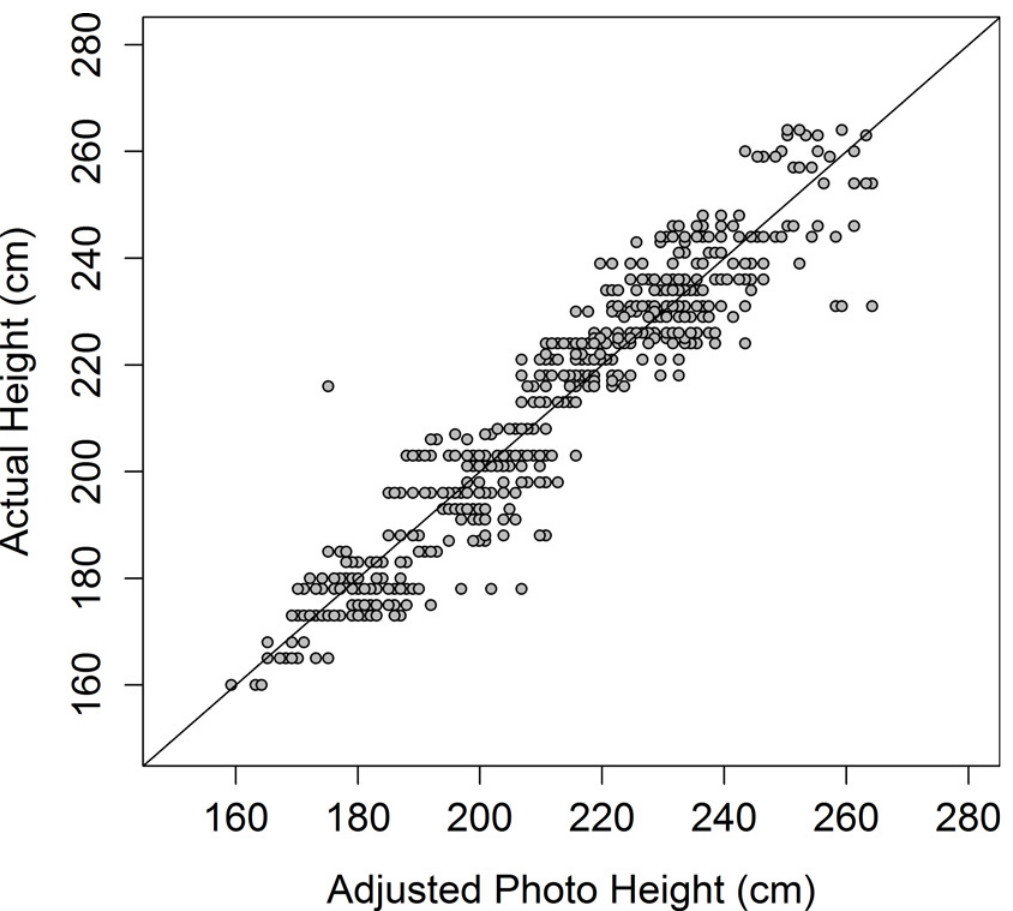
Fig 5. Predicted heights from photos ( n = 151). Photographic heights were adjusted by the equation 10.8 + 0.99 x Photo Height . Dashed line represents 1:1 estimate:actual